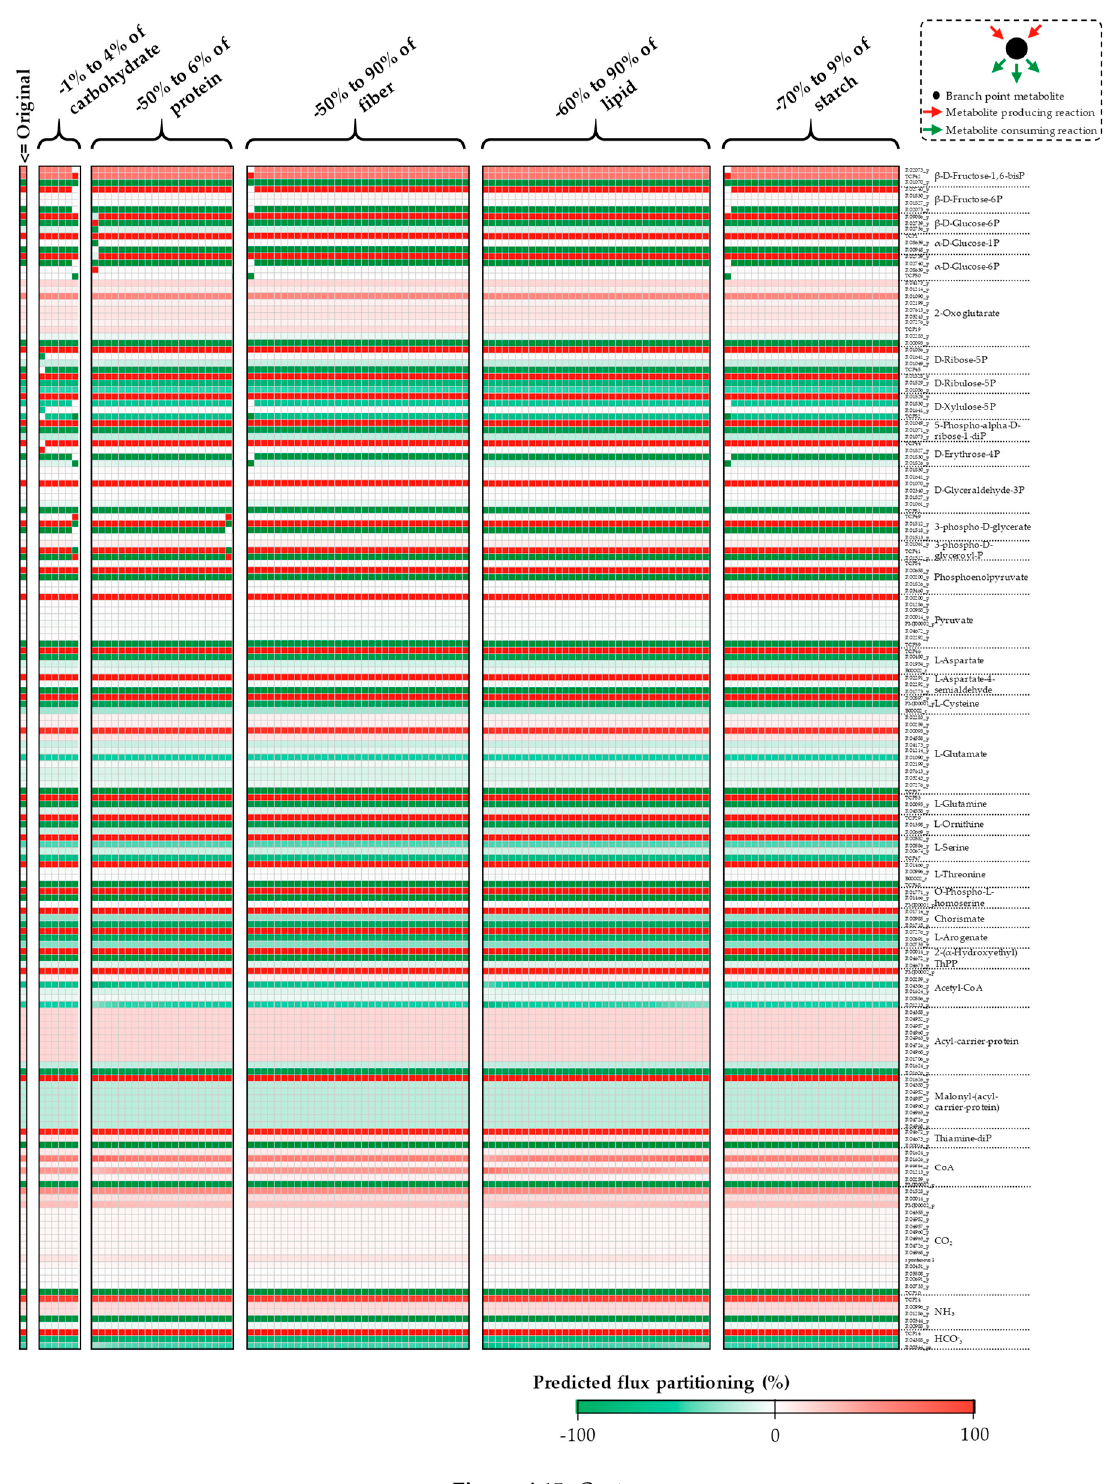
Figure A15. Cont .